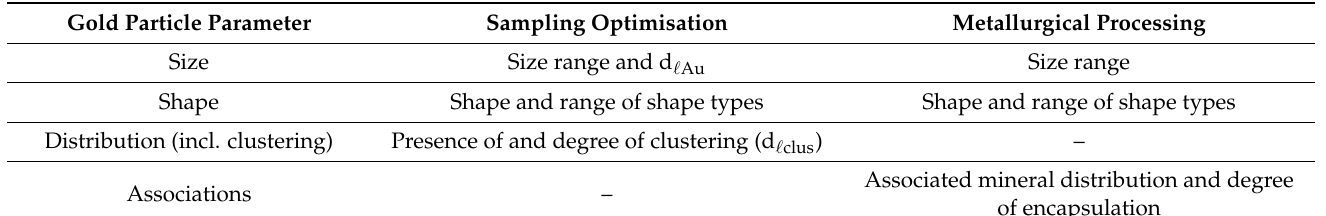
Table 9. Key outputs from XCT that support sampling optimisation and metallurgical evaluation. Gold Particle Parameter Sampling Optimisation Metallurgical Processing Size Size range and d (cid:96) Au Size range Shape Shape and range of shape types Shape and range of shape types Distribution (incl. clustering) Presence of and degree of clustering (d (cid:96) clus ) – Associated mineral distribution and degree Associations – of